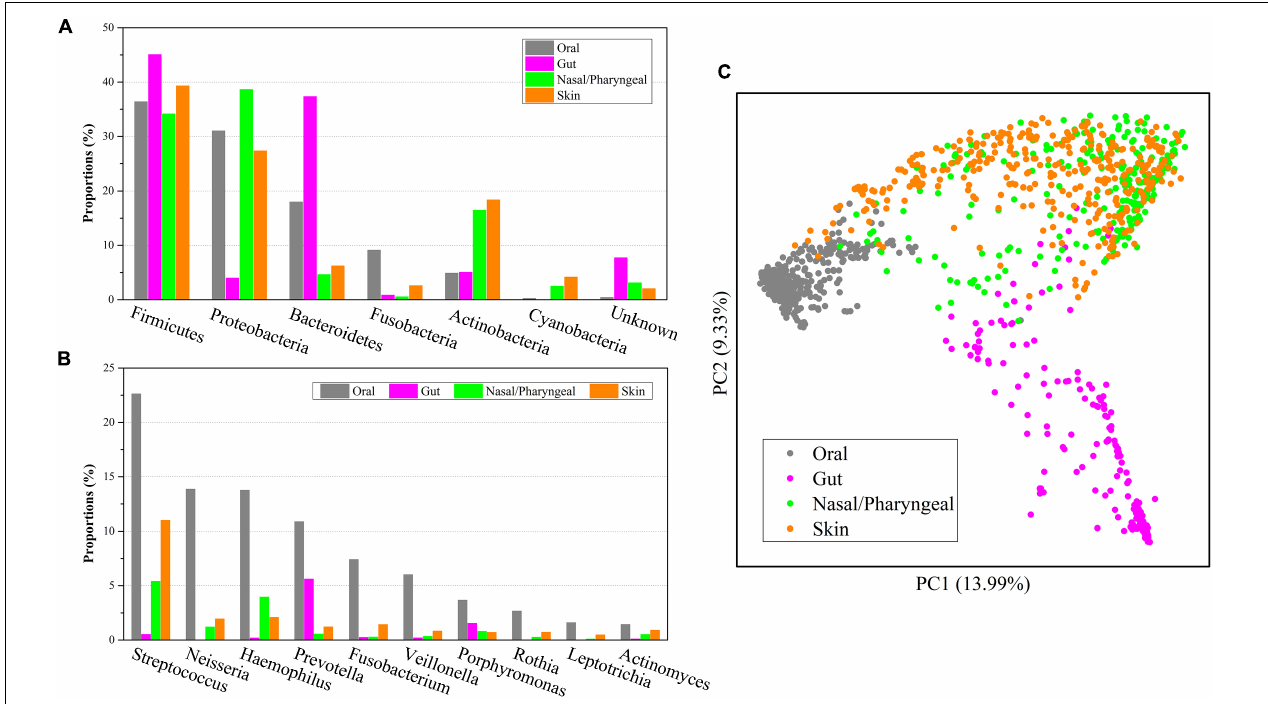
FIGURE 3 | Composition comparisons of human oral saliva, gut, nasal/pharyngeal and skin microbiomes. Distributions of six microbial phyla with the highest abundance (A) and 10 genera with the highest abundance (B) of the oral microbiome in other body parts. PCoA analysis (C) of microbial composition from four different parts of the human oral saliva, gut, nose/pharynx and